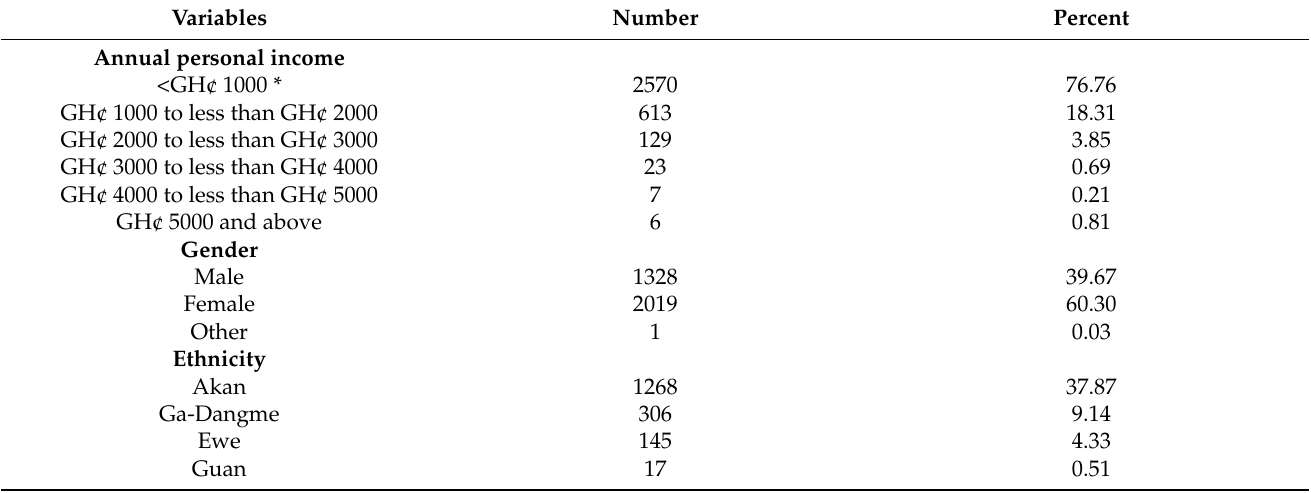
Table 1. Sociodemographic and economic characteristics of study participants (missing observations are indicated; n =